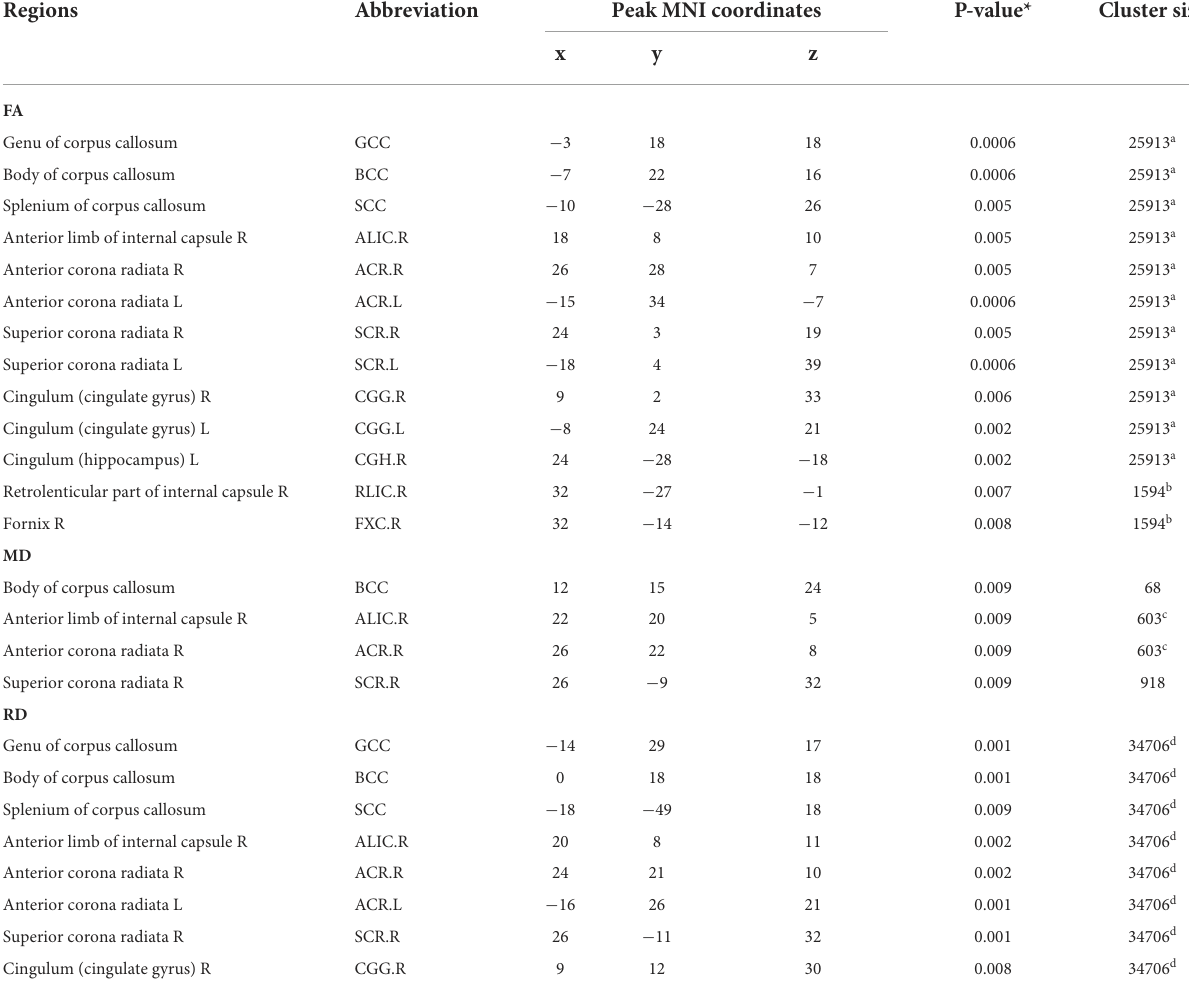
TABLE 2 Clusters with a significant between-group difference by TBSS analysis.